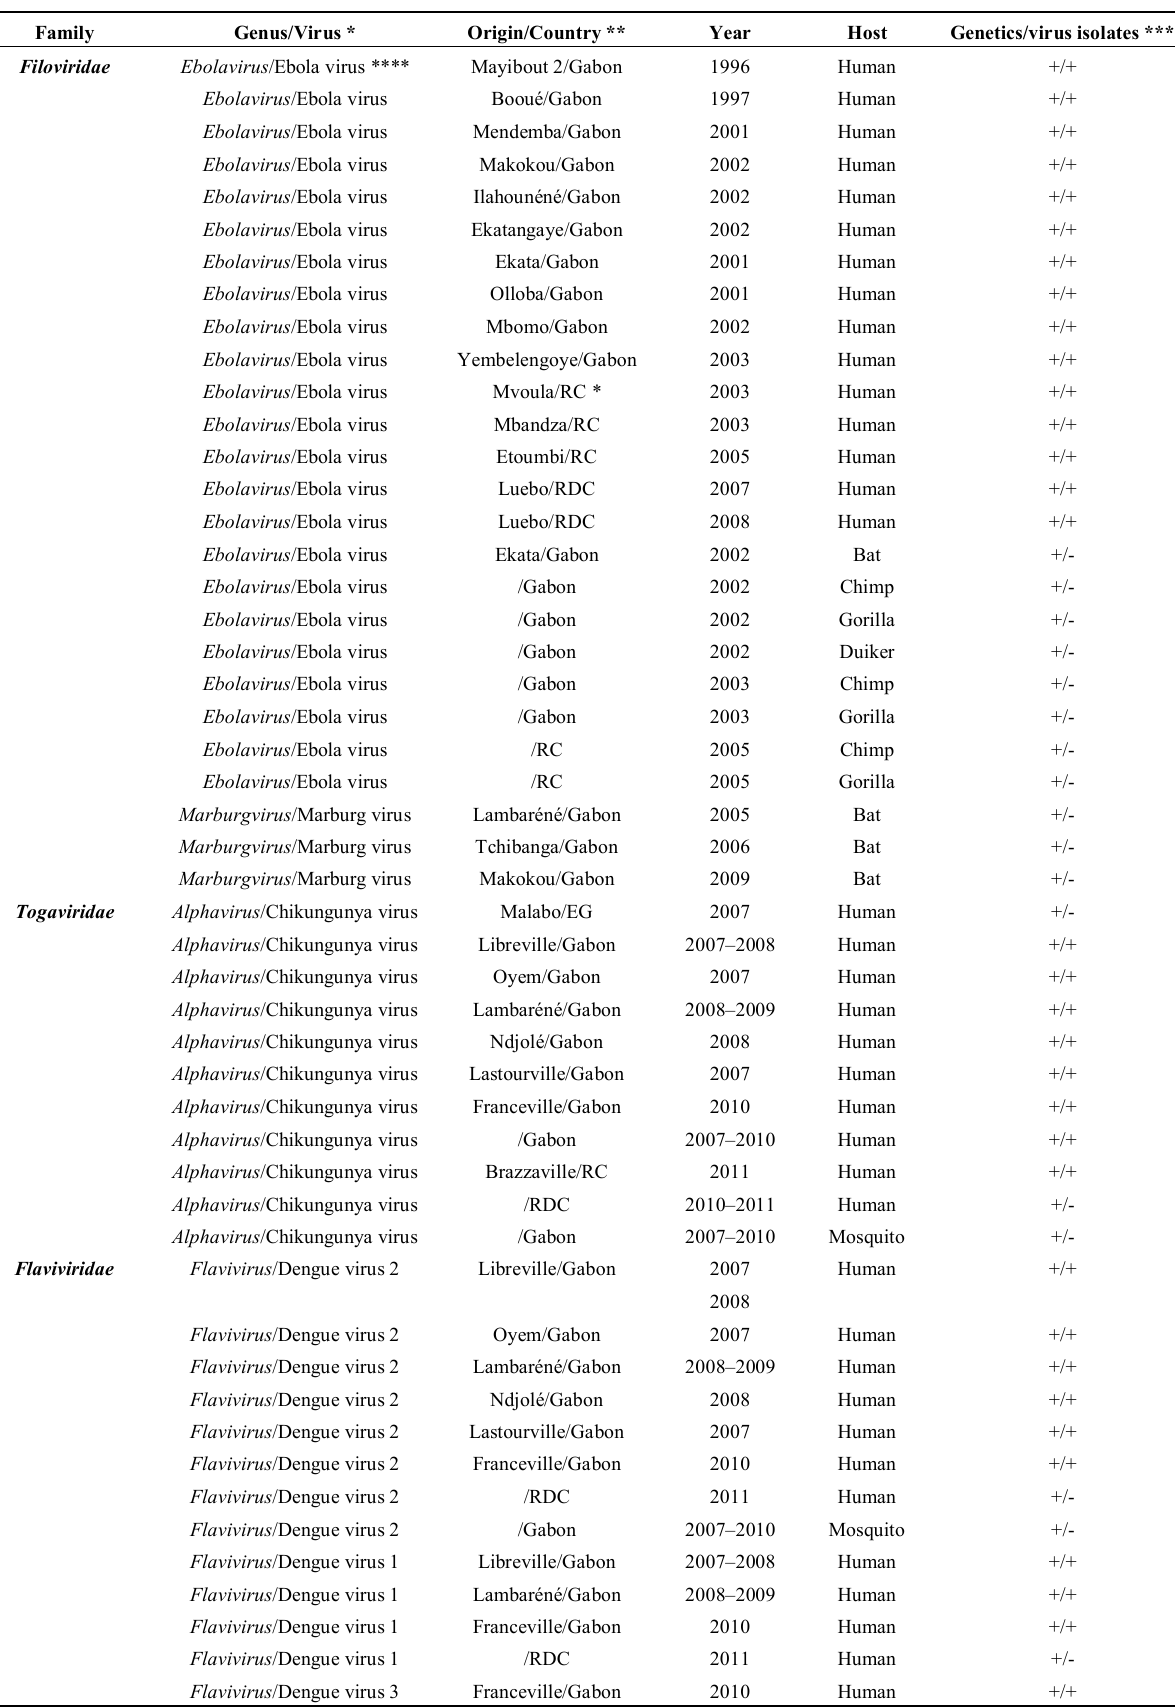
Table 1. Viruses identified by the Emerging Viral Unit using CIRMF high containment facilities.